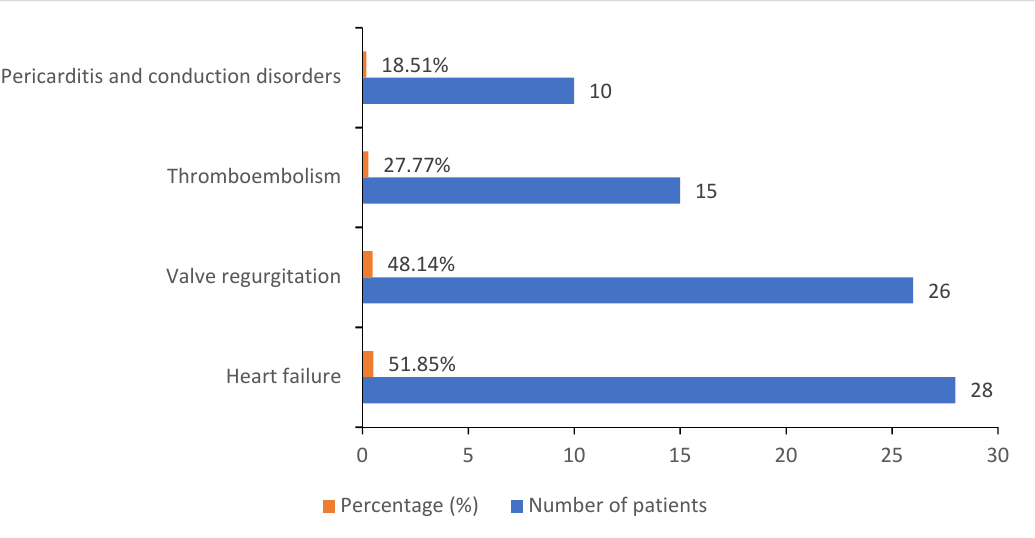
Figure 3. Infective endocarditis complications illustrated in percentages and the corresponding number of cases.